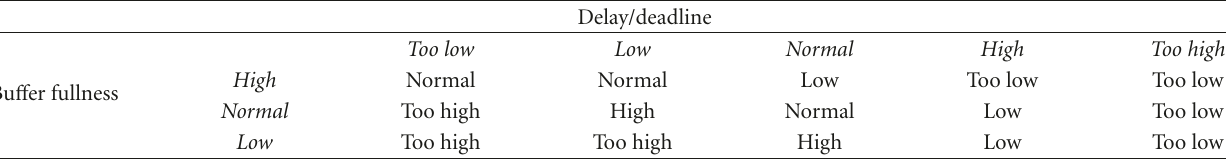
Table 1: FLC stage one if ... then rules used to identify output fuzzy subsets from